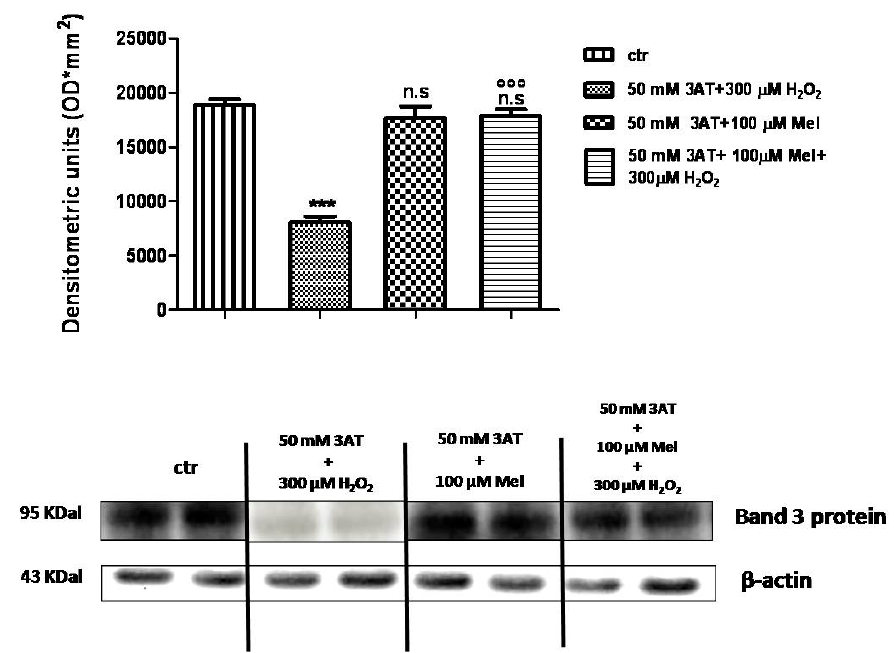
Figure 11. Expression levels of Band 3 protein measured in untreated erythrocytes (ctr), or in 50 mM 3-AT + 300 μ M H 2 O 2 - or in 50 mM 3-AT + 100 μ M Mel or in 50 mM 3-AT + 100 μ M Mel + 300 μ M H 2 O 2 -treated erythrocytes, detected by Western blot analysis. *** p < 0.001 vs. ctr; n.s. not significant vs. ctr; °°° p < 0.001 vs. 50 mM 3-AT + 300 μ M H 2 O 2 , as determined by one way ANOVA followed by Bonferroni’s post hoc test (N = 5).